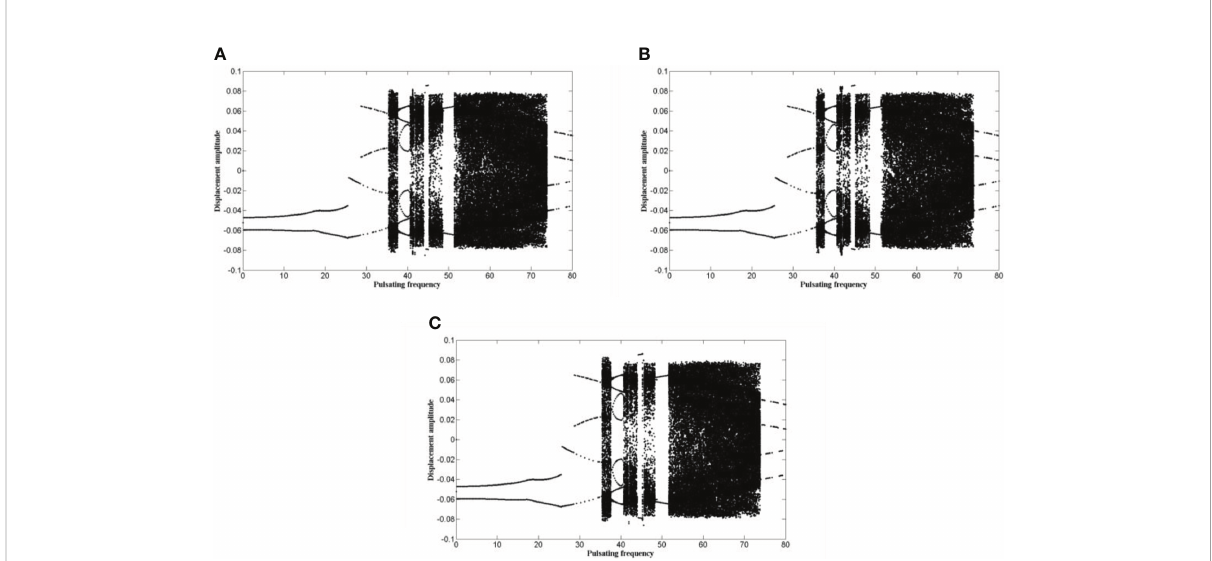
FIGURE 3 The bifurcation diagrams for the midpoint of the pipe, under different Galerkin truncations N (in which υ =8, u 0 = 4.5 and the control parameter is w p ): (A) N=4 ; (B) N=6 ; (C) N=8 .